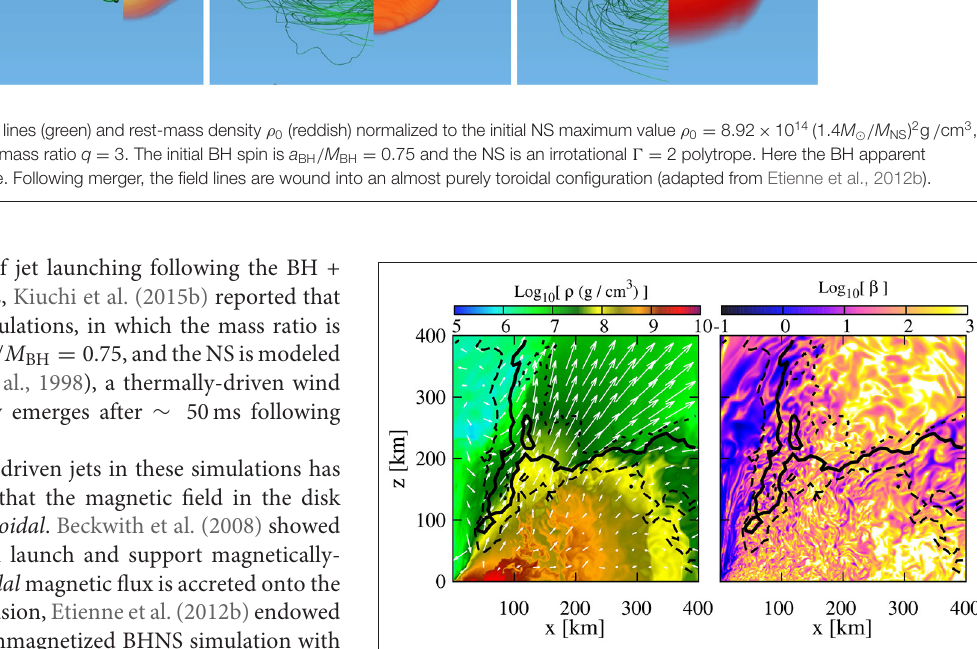
FIGURE 2 | NS rest-mass density with fluid velocity arrows (left) and the gas-to-magnetic-pressure ratio (right) of a q = 4 BHNS remnant after ∼ 50ms following merger. A thermally-driven wind (but no collimated) outflow is observed (from Kiuchi et al.,